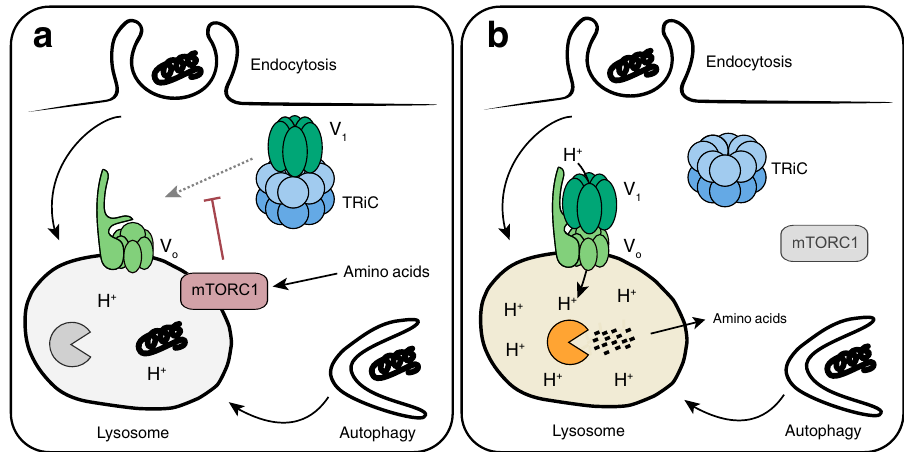
Fig. 7 | mTORC1 controls lysosomal catabolic activity by regulating V-ATPase assembly. Modelforthe regulationof lysosomalcatabolicactivitybymTORC1. a Underaminoacid-repleteconditions,alargefractionofV-ATPaseV 1 domains is stabilized in the cytosol by association with the chaperonin TRiC. Conse- quently, lysosomes display an elevated pH and low catabolic activity. b Upon